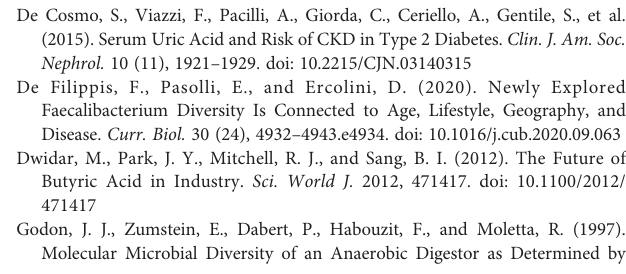
Supplementary Figure 1 | Reasonable sequencing data and different fecal microbial diversity in the subgroup analysis. (A) Rank-abundance curves indicated that the amount of sequencing data is reasonable. Bacterial richness and diversity (including richness and evenness) were assessed by Chao index (P= 0.008; B ) and Shannon index (P= 0.001; C ). (D) NMDS analysis based on bray-curtis indicated distinct microbial community between the two groups. NMDS: non-metric multidimensional scaling. Supplementary Figure 2 | (A – E) Differences in gut microbiota at all levels. The N_UA and A_UA groups had signi fi cantly different relative abundances. Supplementary Figure 3 | Composition of the microbial communities of healthy controls and diabetic patients with high uric acid levels. Supplementary Figure 4 | Differential bacteria and metabolic pathways were showed after grouping according to the international hyperuricemia standard. Supplementary Figure 5 | After grouping by age, the difference in gut microbiota between DM withlow uricacid and DM withhigh uricacid. (A) age<=40y, (B) 40y < age <55y, (C) age